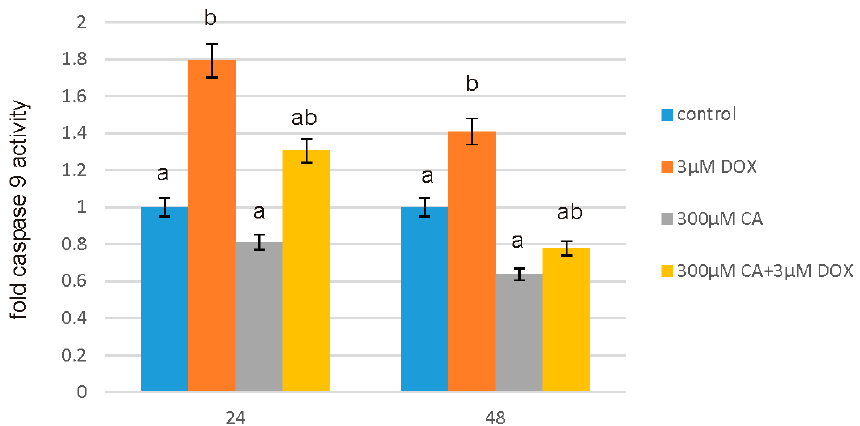
Figure 5. The effect of DOX, CA and CA+DOX on caspase 9 activity in fibroblast cells. The cells were incubated with 3 µ M DOX, 300 µ M CA and DOX (3 µ M) combined with CA (300 µ M) for 24 h and 48 h Mean values from three independent experiments ± SD are shown. Different letters (a, b) indicate statistical differences ( p ≤ 0.05) between control, 3 µ M DOX, 300 µ M CA and DOX combined with CA estimated by Tukey’s